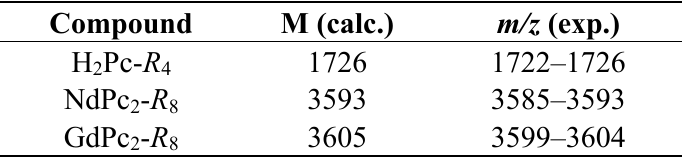
Table 1. Mass spectra m/z results (MALDI-ToF) acquired for the novel bis-phthalocyanines of Nd and Gd, and the metal-free base phthalocyanine and the calculated molecular mass (M). (For more data see Supplementary Information appendix).